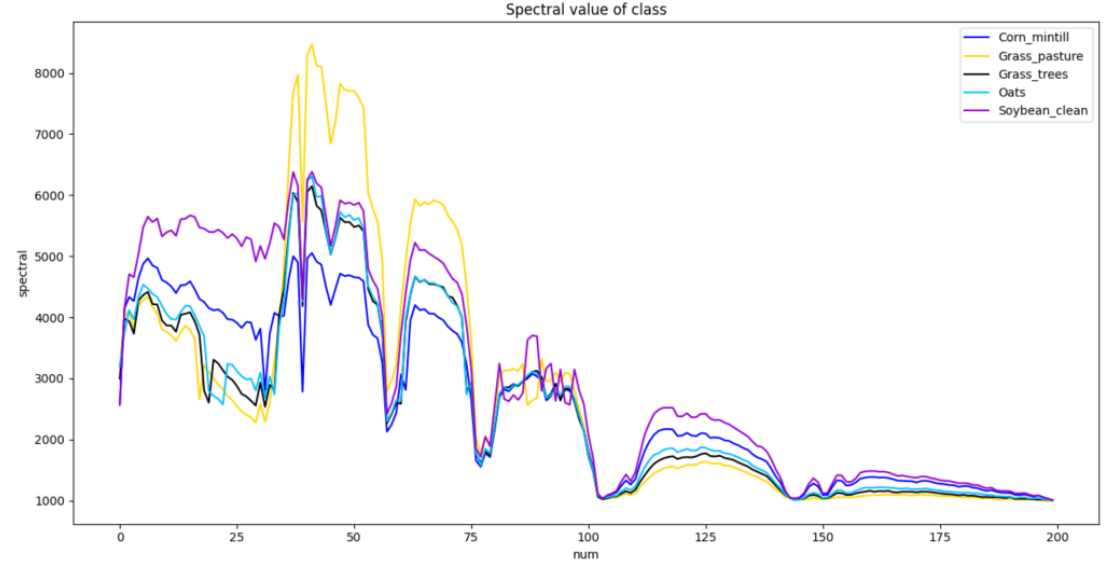
Figure 12. Spectral curves of Oats and its surrounding four types of samples.